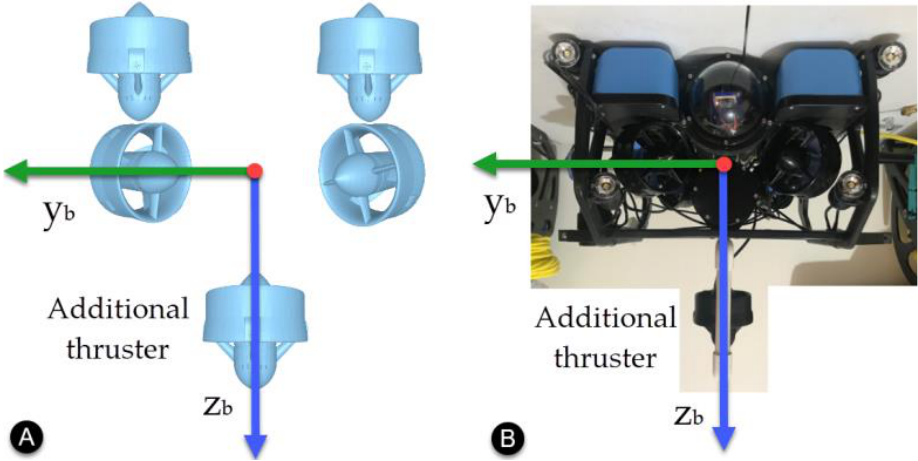
Figure 5. Additional thruster for external disturbance. ( A ) Front view diagram. ( B ) Implementation.